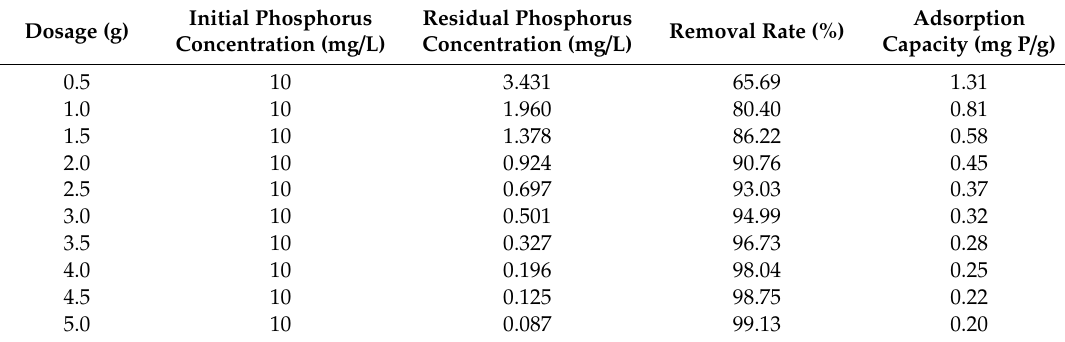
Table 5. E ff ect of dosage of ZSFB composite fiber on phosphorus